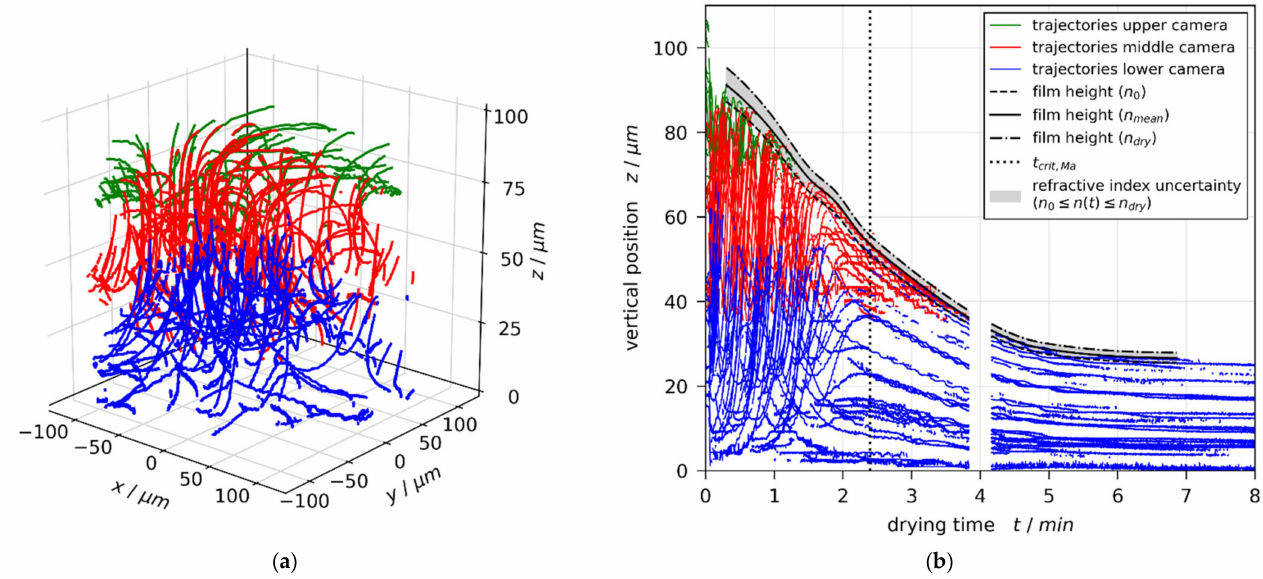
Figure 1. Flow field in a poly (vinyl acetate)-methanol film ( X 0 = 1.5 g /g and coating gap h gap = 200 µ m), drying MeOH PVAc at T substrate = 20 ◦ C and otherwise ambient conditions, measured with µ PTV and evaluated with mean refractive index. The flow field clearly shows convective instabilities. ( a ) 3D tracer-particle trajectories. ( b ) Transient vertical tracer particle positions. The convective instability stops during drying at t crit , Ma = 144 s. Since the reconstruction of vertical particle positions from observed diffraction rings depends on the refractive index of the drying film, the extracted drying curve (black curves) is additionally given for an evaluation with the refractive index of the coating solution n 0 and the dry polymer n dry , respectively. Reprint from [1], License: CC-BY